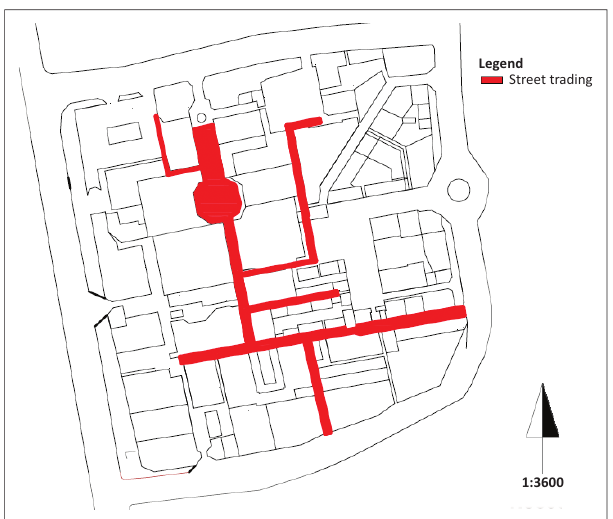
FIGURE 7: Street trading areas.